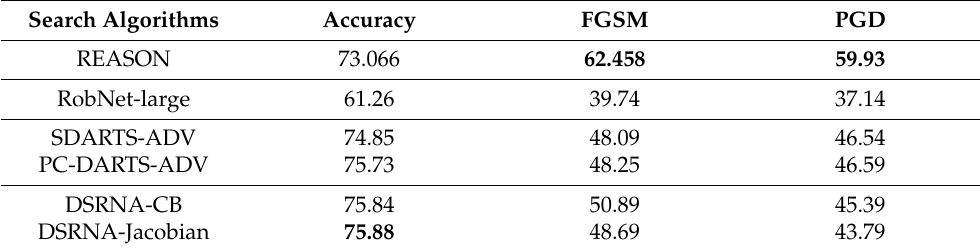
Table 3. Comparison of search